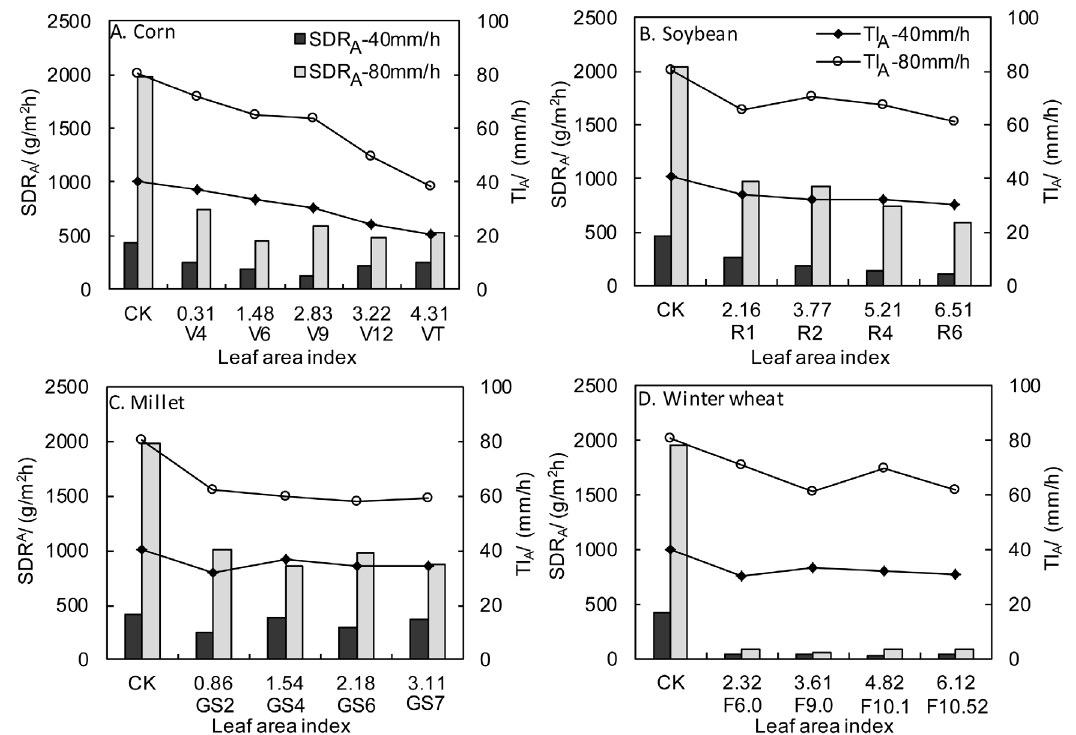
Figure 3. Relationship between throughfall and average splash detachment rate under crop canopy.